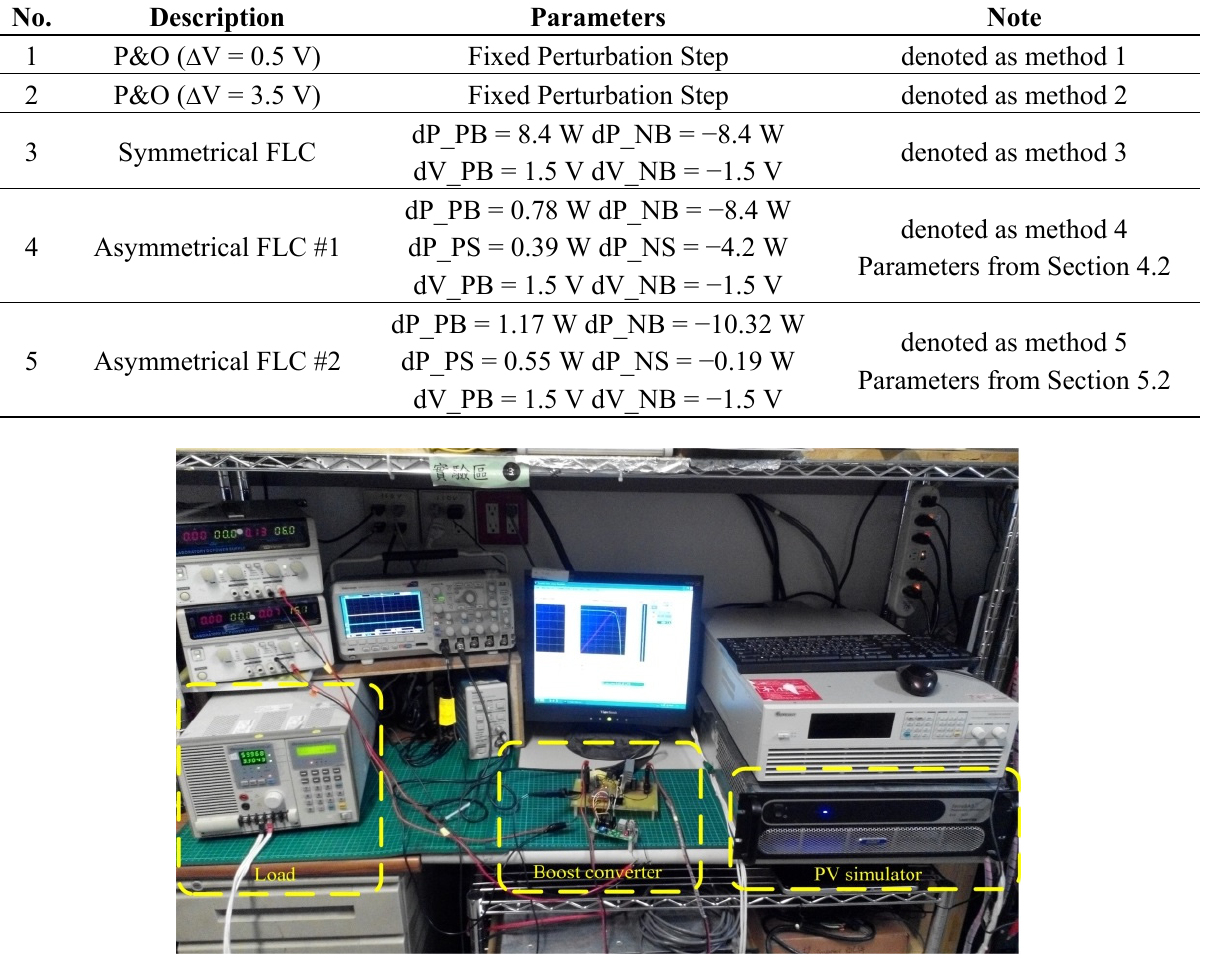
Figure 13. Experimental setup and the testing